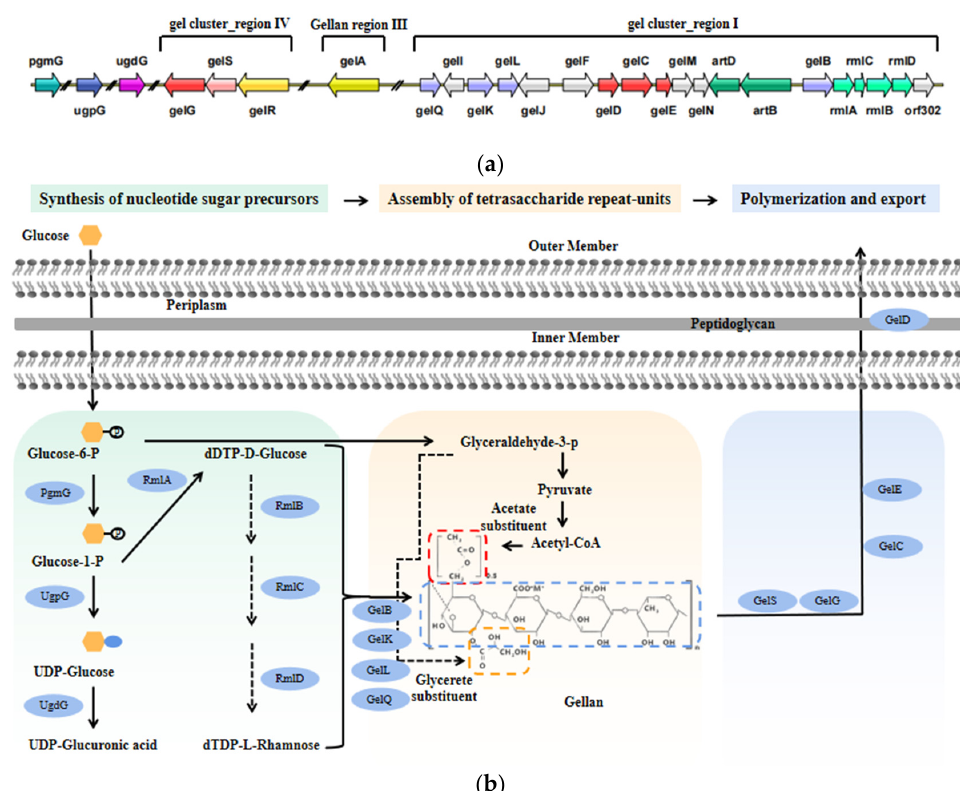
Figure 1. ( a ) Organization of the gellan biosynthesis gene clusters (regions I and IV) and gellan region III from S. elodea ATCC 31461, adapted from [36], Oxford University Press, 2002. ( b ) Schematic drawing of gellan biosynthesis, adapted from Li et al. [32], ASM Journals, 2019.